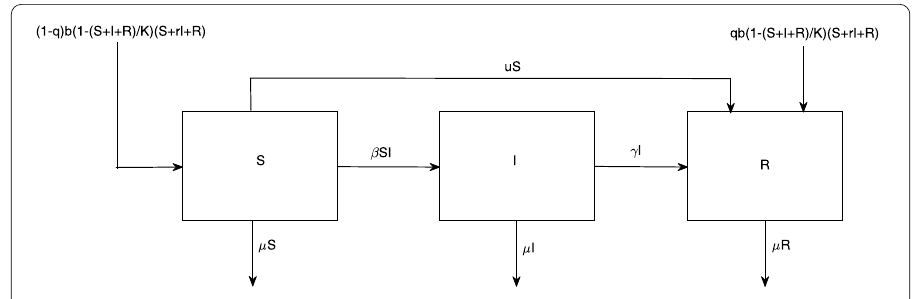
Figure 1 A flow diagram for describing the transmission dynamics of PRRSV among the swine population. In the diagram, S , I , and R represent susceptible, infected, and recovered swines. PRRSV is transmitted at rate β ; swines are recovered at rate γ . PRRSV may cause a reproductive failure so that only the proportion r of swines successfully reproduces. Generally, births occur at rate b and swines die at rate μ . Swines are vaccinated at births with the vaccination coverage q and vaccinated at rate u from a susceptible